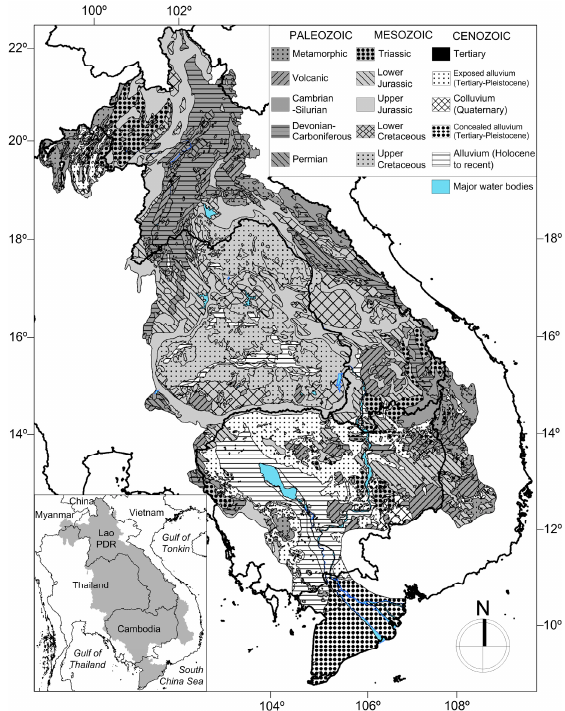
Figure 2. Geology of the Lower Mekong Basin, adapted from [19].